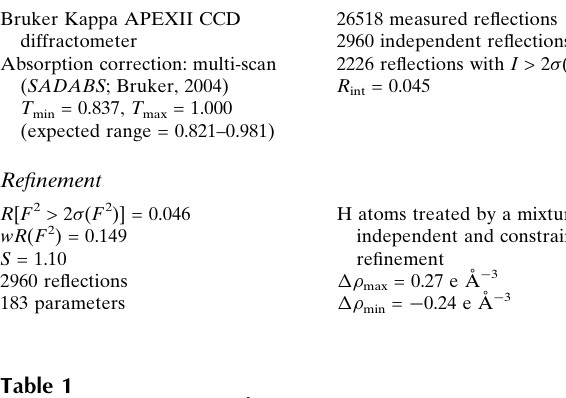
Hydrogen-bond geometry (A˚ , (cid:1)